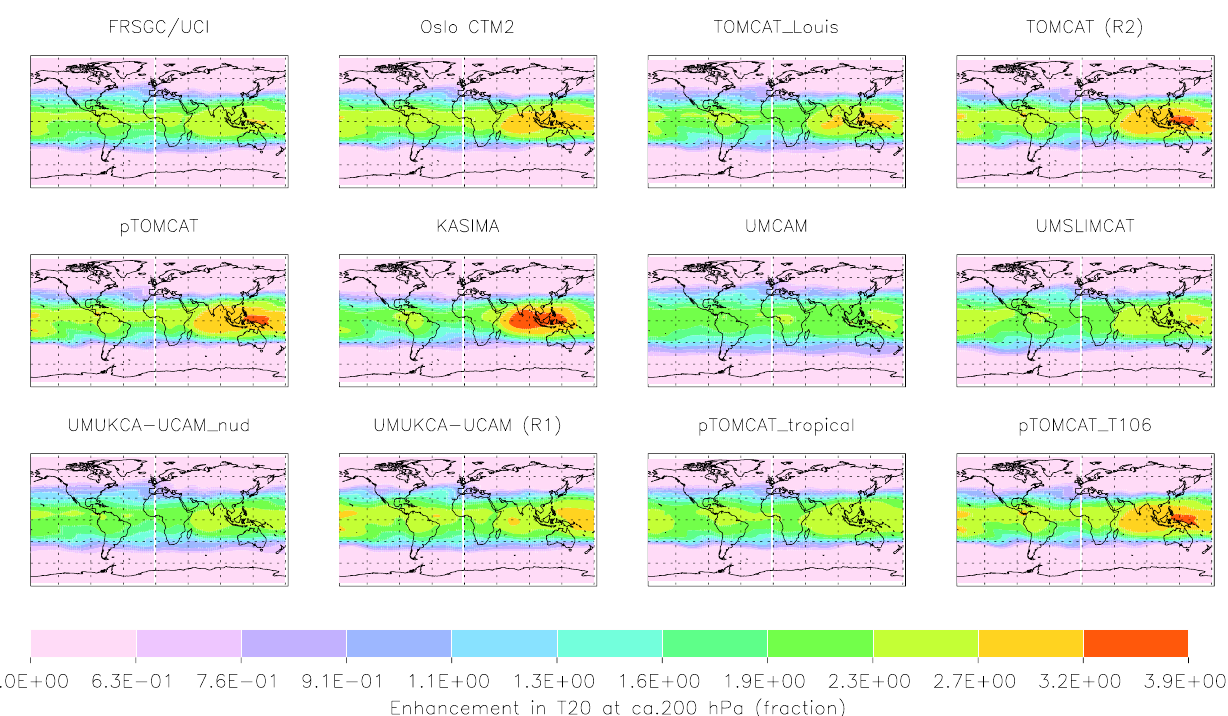
Fig. 5. The fraction enhancement of the 2005 annual mean mixing ratio of the T20 tracer, for each model, at the 200hPa level. The enhancement was calculated by dividing the value at a particular point by the global mean at that